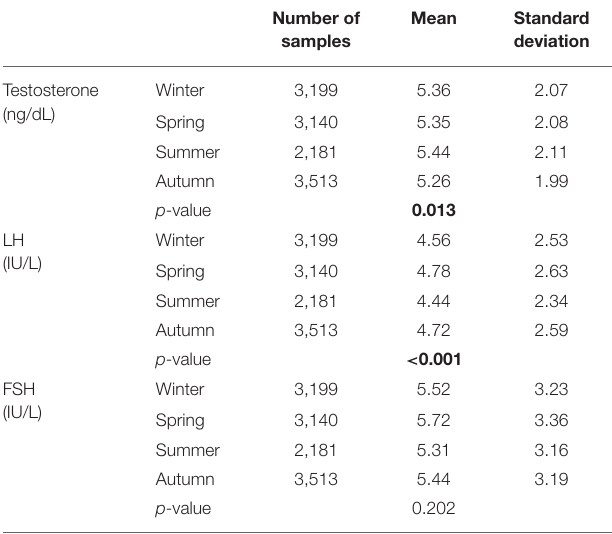
TABLE 1 | Hormone serum levels in the four seasons across the study